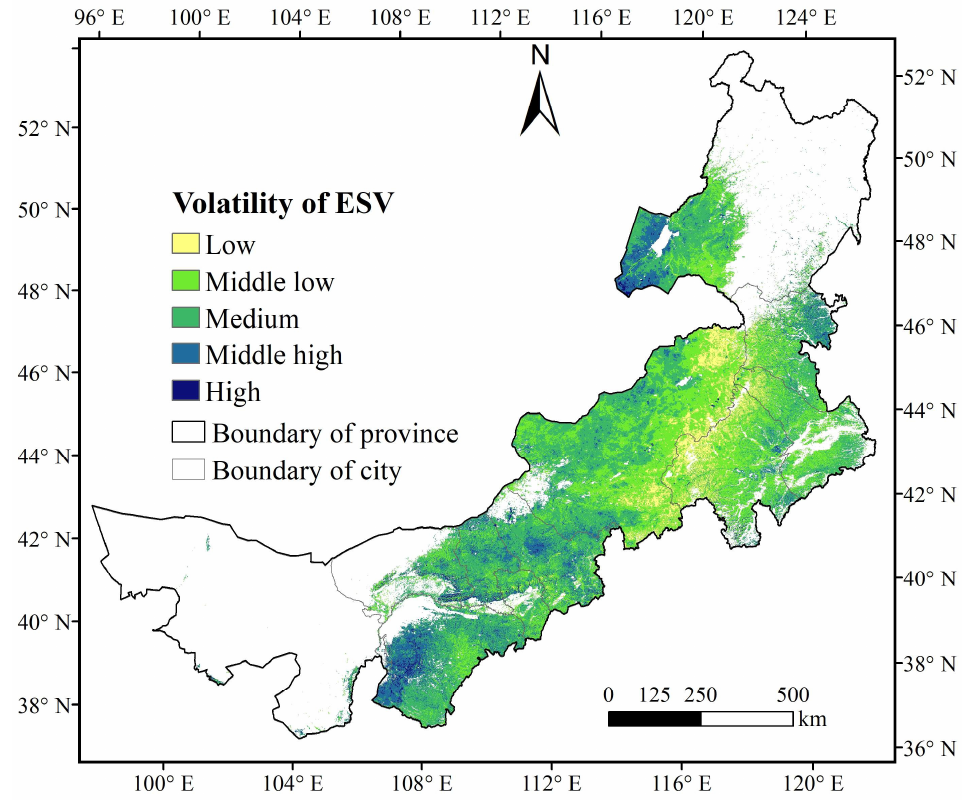
Figure 6. The fluctuation characteristics of grassland ESV in Inner Mongolia from 2000 to 2019. The volatility of grassland ESV in Inner Mongolia from 2000 to 2019 was mainly middle low and medium volatility, accounting for 34.30% and 44.90%, respectively (Table 5). The average volatility was 0.16. This means that the ESV of most areas in the study area fluctuated little from 2000 to 2019, and the grassland ecosystem is relatively stable. Table 5. Area ratio with different volatility level of grassland ESV in Inner Mongolia from 2000 to 2019. The Volatility of ESV Area Ratio (%) Low volatility ( CV < 0.1)